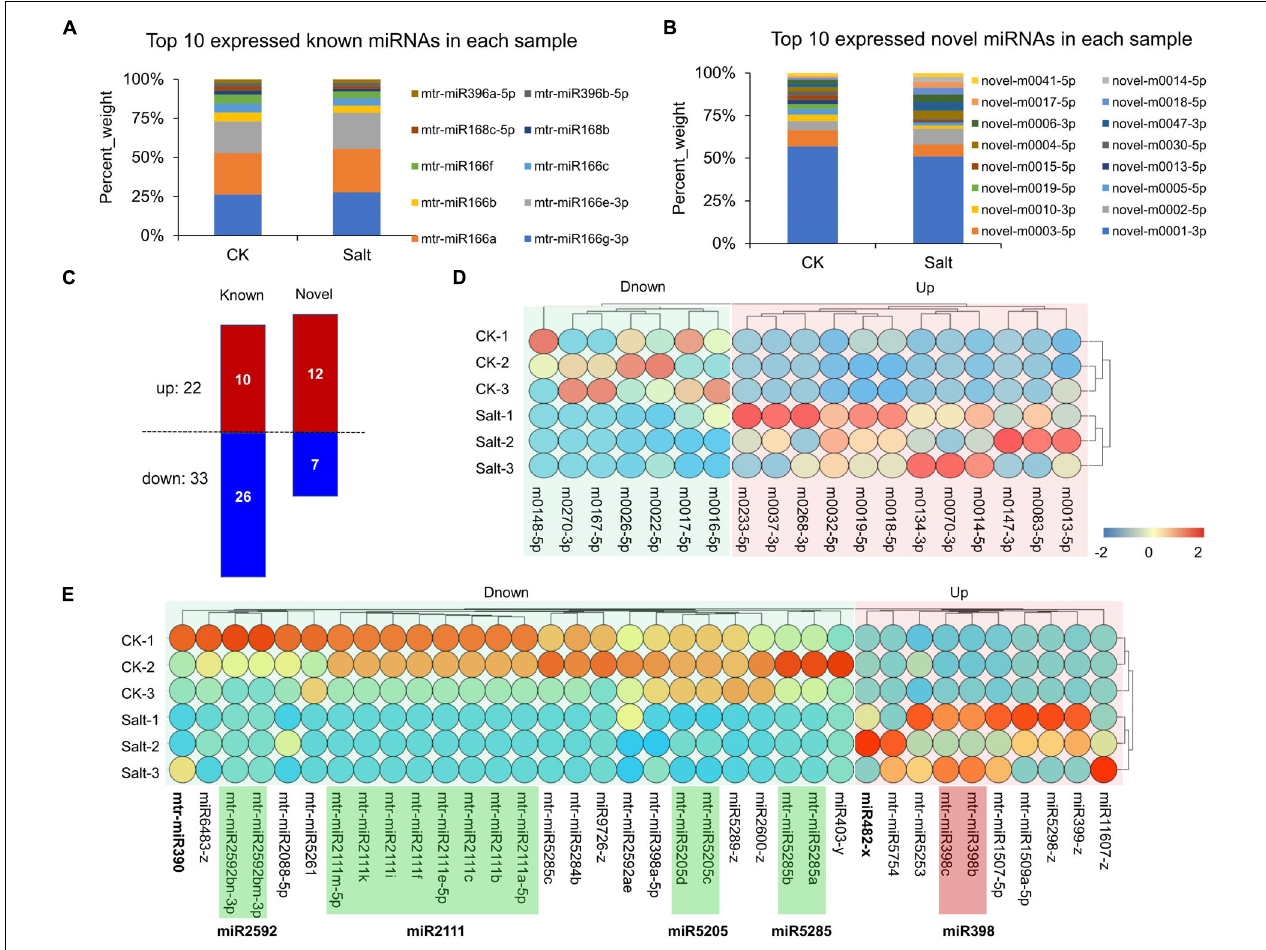
FIGURE 8 | Expression analysis of miRNAs. (A) Top 10 expressions of known miRNAs in the CK and Salt groups. (B) Top 10 expressions of novel miRNAs in the CK and Salt groups. (C) Statistics of down-regulated and up-regulated DEmiRNAs. (D) Expression visualization of novel DEmiRNAs in six samples. (E) Expression visualization of known DEmiRNAs in six